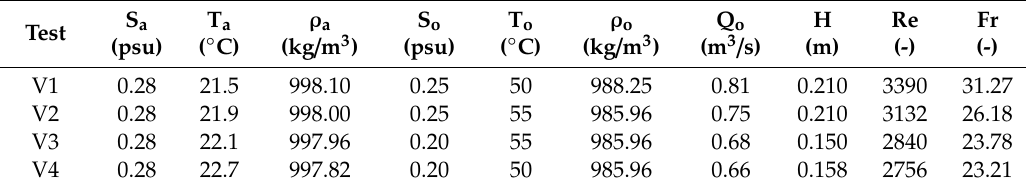
Table 1. Summary of the characteristics of the physical tests (V1 to